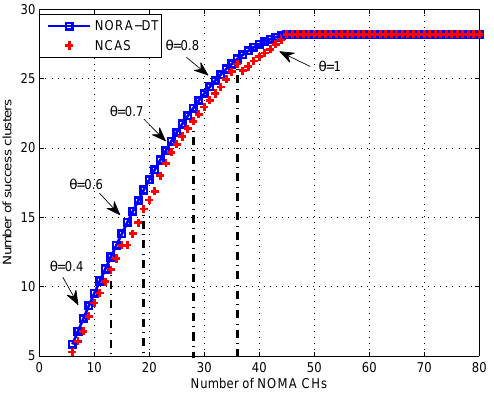
Figure 4. Comparison of the number of success clusters among non-orthogonal random access and transmission (NORA-DT) and NOMA-based congestion-alleviating access scheme (NCAS).